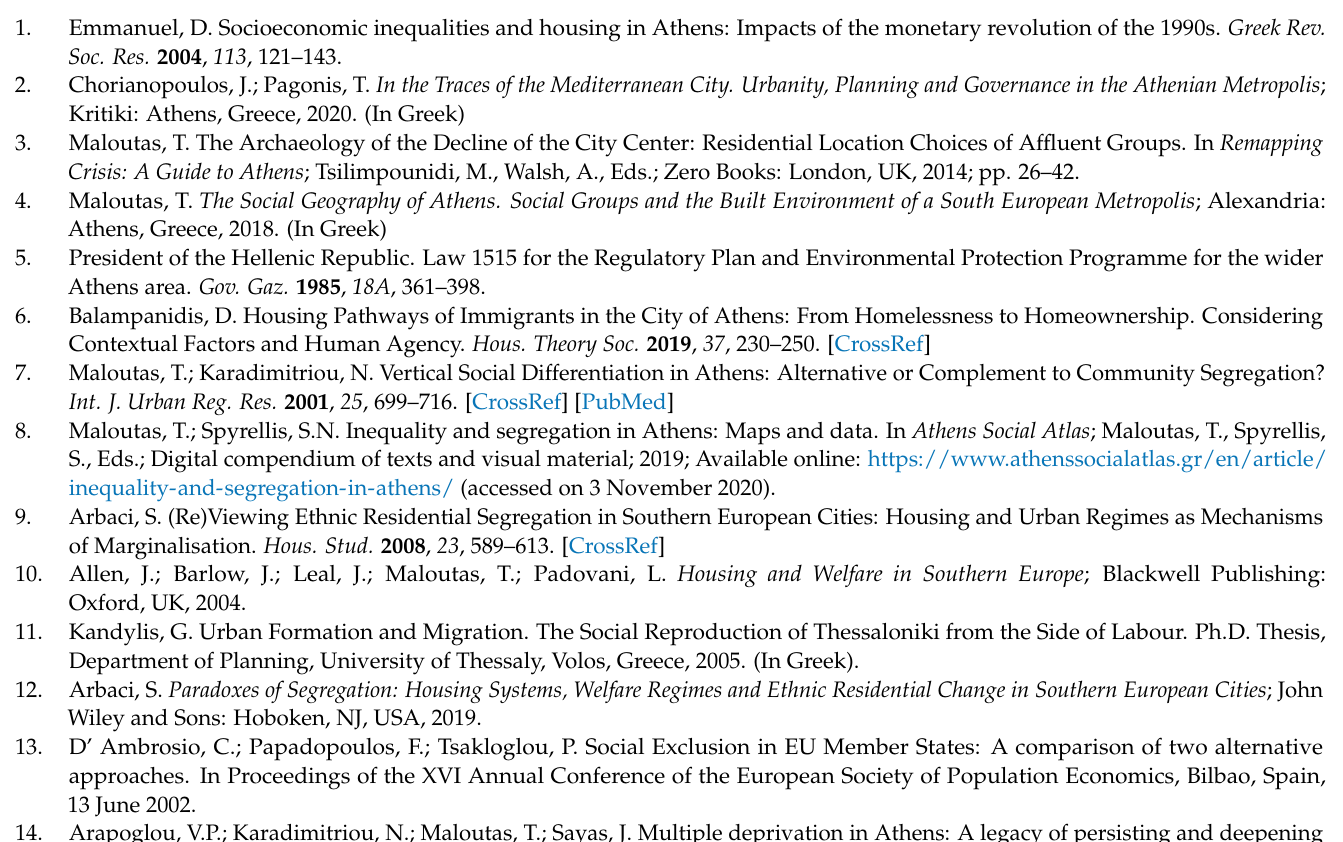
Table S5. Distribution of Athenian spatial units (URANU) within the 2011 deprivation clusters by their respective deprivation status in